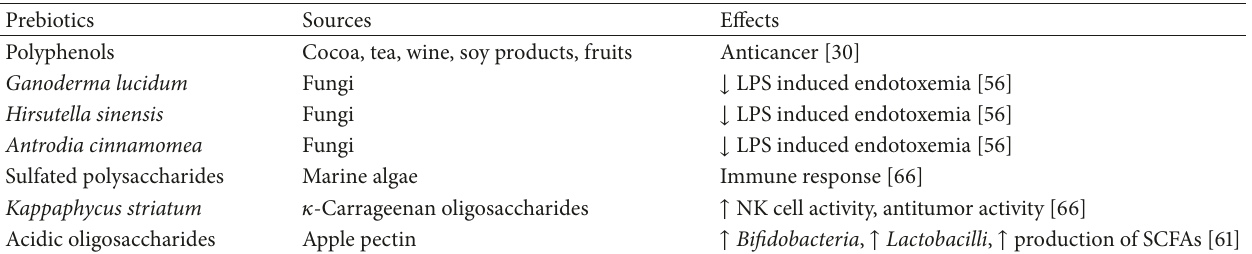
Table 1: Showing sources and effects of different